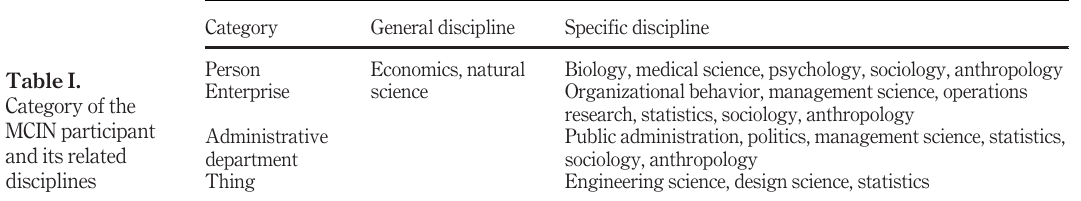
Table I. Category of the MCIN participant and its related